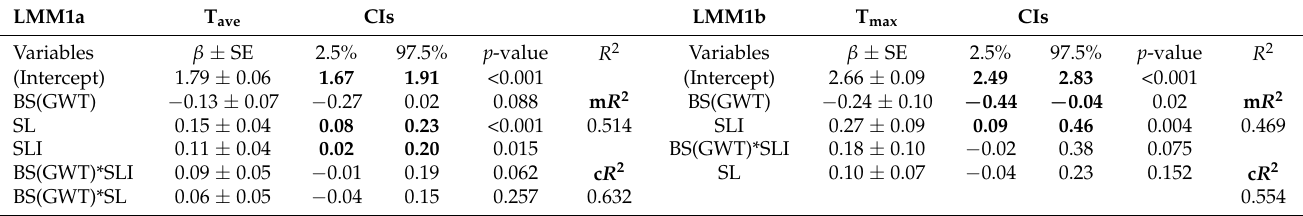
Table 3. Summary of averaged models for the average (T ave ) and maximum (T max ) retention time of recovered seeds, for the percentage of recovered (Retrieval) and germinated seeds (Germination), for the retention time interval on recovered and germinated seeds, and for treatment (TT) according to alternation of GLMMs (see Table S1), including parameter estimates ( β ), standard errors ( ± SE) and confidence intervals, as well as the R 2 of the top model represented the model fitting effect. The confidence intervals (CIs) were in bold if they did not overlap zero, indicating significant variables. The p -value explained the significance level of the variables. * refers to interaction of fixed